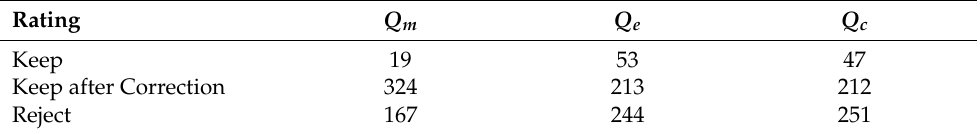
Table 3. Breakdown of the number of ratings (N = 510) per aggregation and class